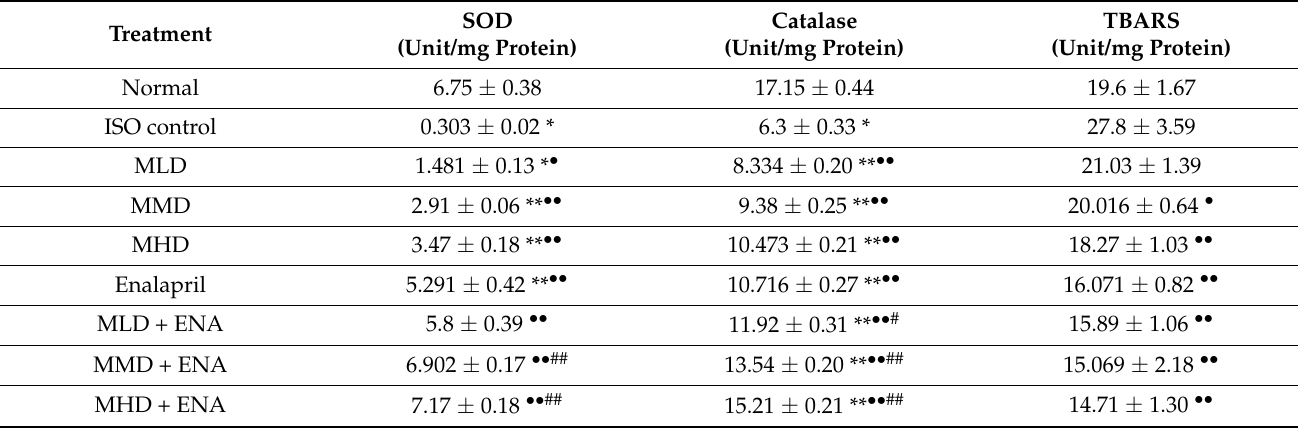
Table 2. Effects on SOD, catalase, and thiobarbituric acid reactive species (TBARS) activity in heart tissue homogenate against isoprenaline-induced acute myocardial